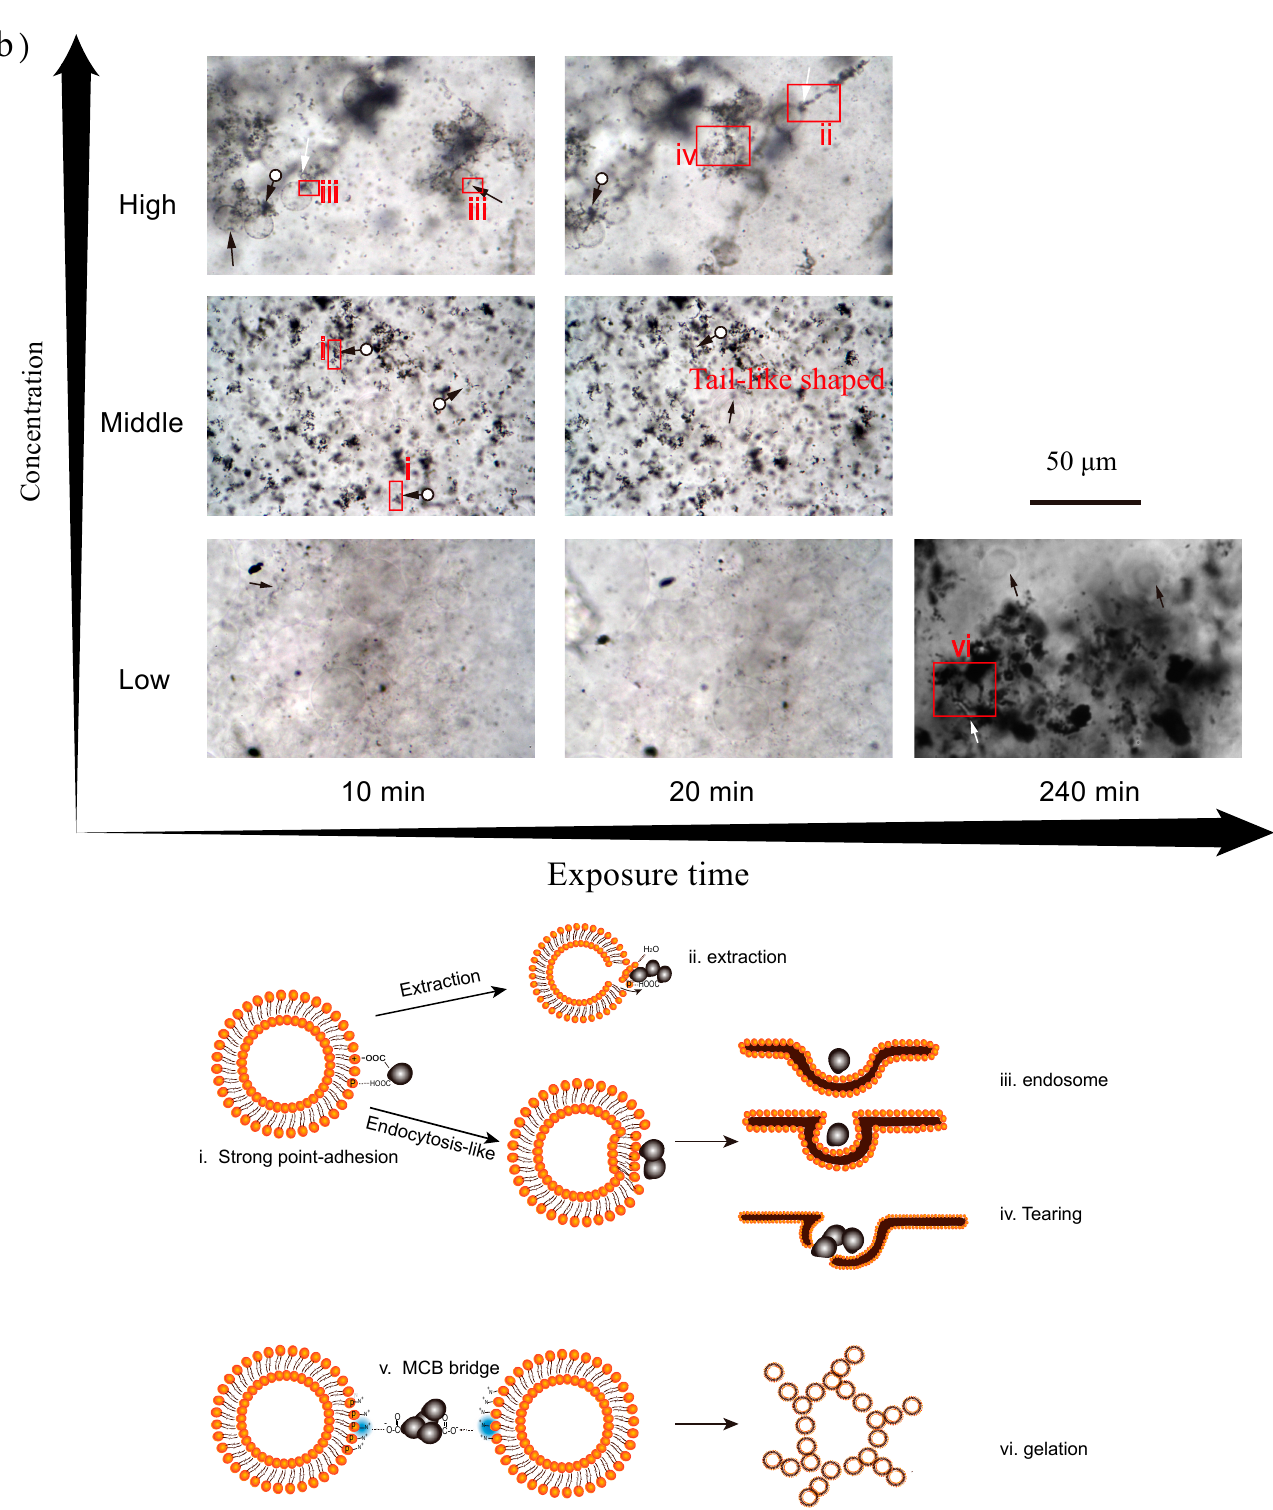
Figure 5. Morphological changes of GUV + at different exposure times in different concentrations of CB ( a ) and MCB ( b ). The black arrow indicates the deformed GUV. White arrows mark phospholipid fragments extracted by nanoparticles. Circled arrows indicate nanoparticles covering the vesicles. Right of ( a ) from i to iii and down of ( b ) from i to vi are modeling selective box areas marked with i to vi (orange beads and brown lines: head groups and tails of lipids; black ball: nanoparticles). High (104 mg/L for CB and 120 mg/L for MCB), Middle (67 mg/L for CB and 77 mg/L for MCB), and Low (21 mg/L for CB and 25 mg/L for MCB) in the exposure experiment.